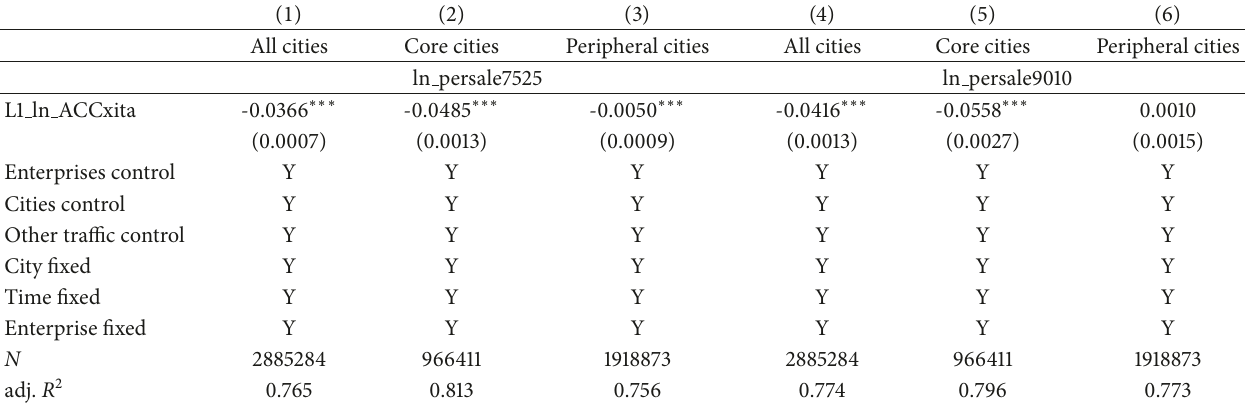
Table 7: Regression analysis of market access and resource